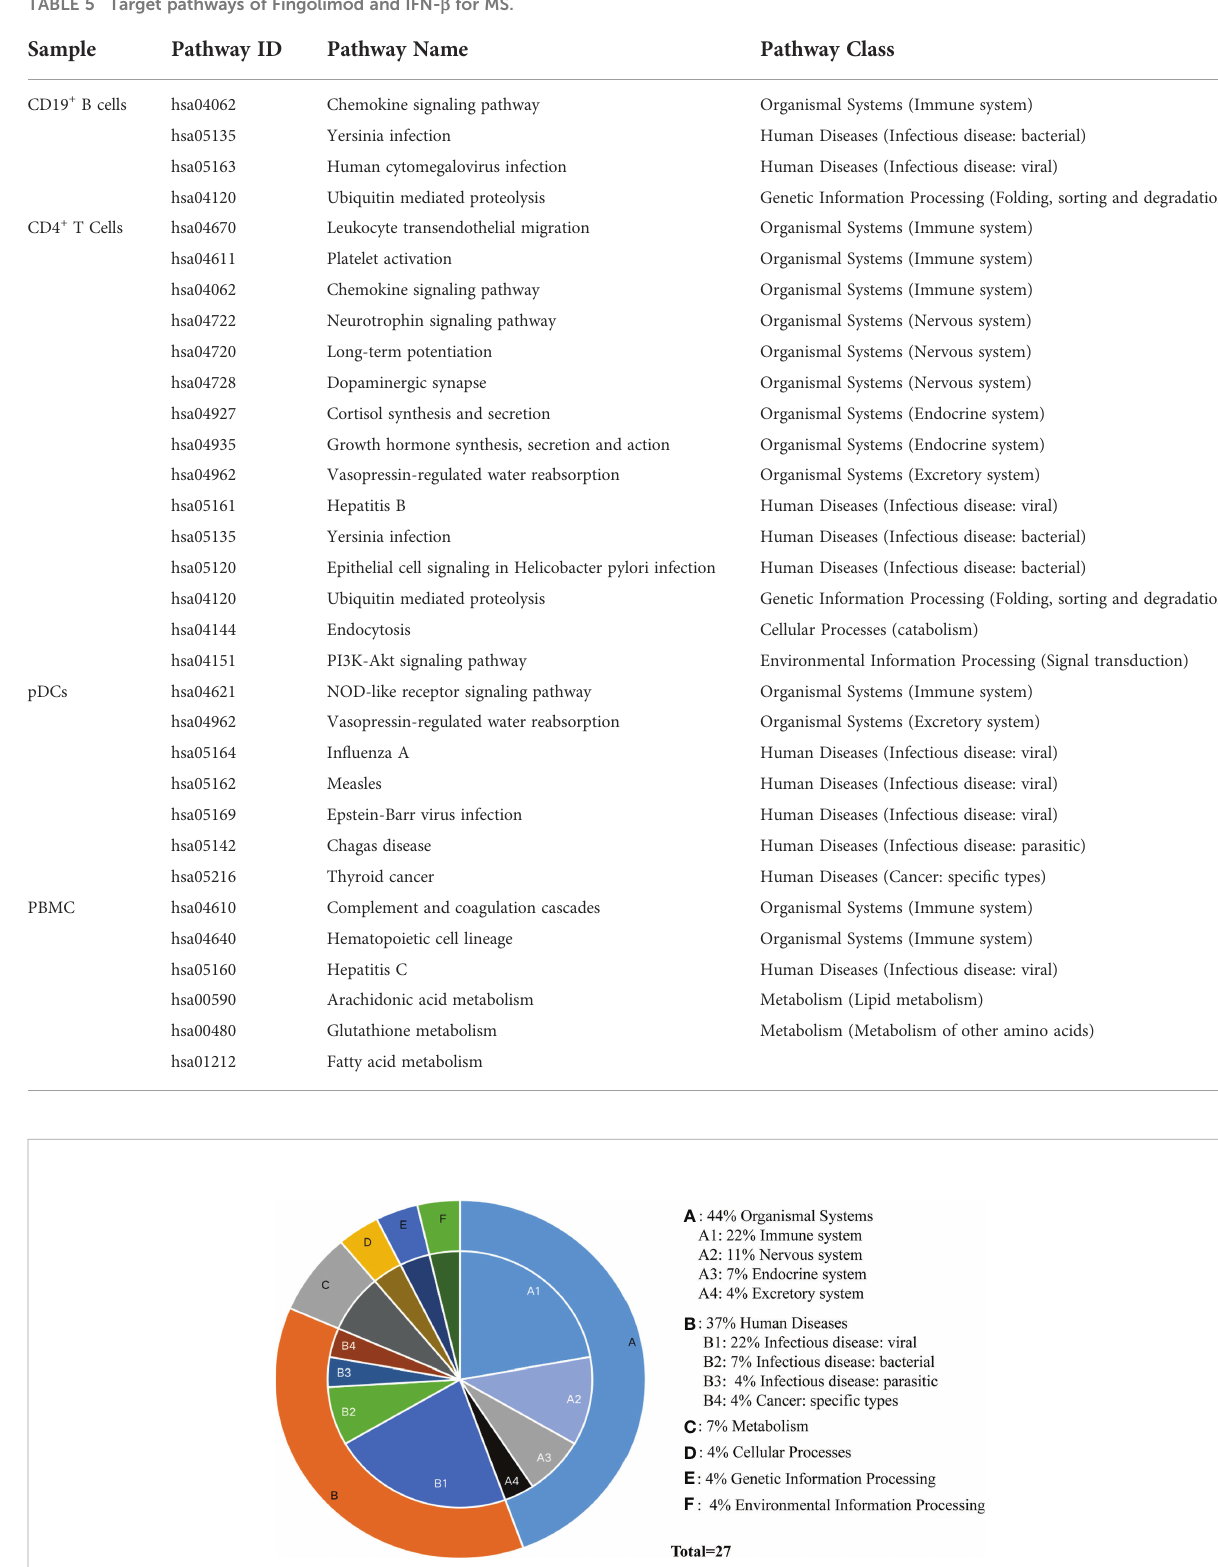
TABLE 5 Target pathways of Fingolimod and IFN- b for MS.